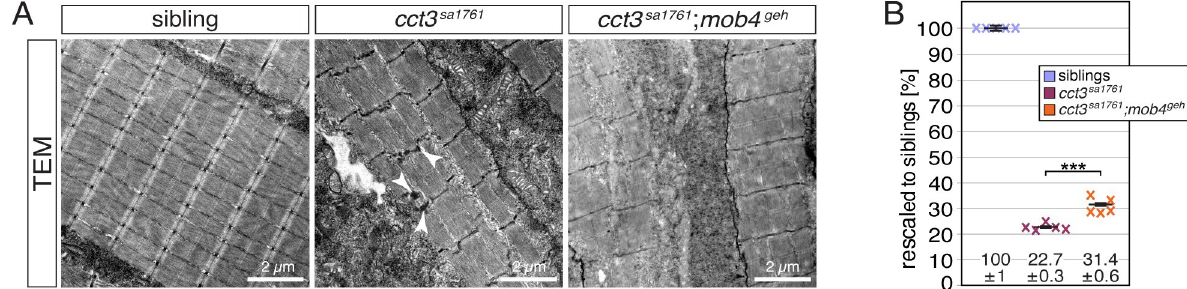
Fig 5. Mob4 interacts with TRiC. (A) As depicted in transmission electron micrographs, the sarcomere organisation detected in siblings was compromised in single cct3 sa1761 homozygotes as well as cct3 sa1761 ; mob4 geh compound homozygotes. Electron-dense aggregates (arrowhead) as found in cct3 sa1761 homozygotes were absent in cct3 sa1761 ; mob4 geh compound homozygotes (n = 3 per genotype). Scale bar sizes are 2 μ m. (B) After rescaling to siblings (100 ± 1%), the birefringence of cct3 sa1761 ; mob4 geh compound homozygotes (31.4 ± 0.6%) was significantly ameliorated compared to single cct3 sa1761 homozygotes (22.7 ± 0.3%). Crosses represent averaged birefringence of clutches with a minimum of 4 larvae per genotype (n = 5 clutches). Data are presented as mean ± SEM; ��� P < 0.001 by one-way ANOVA with post hoc Tukey’s test.